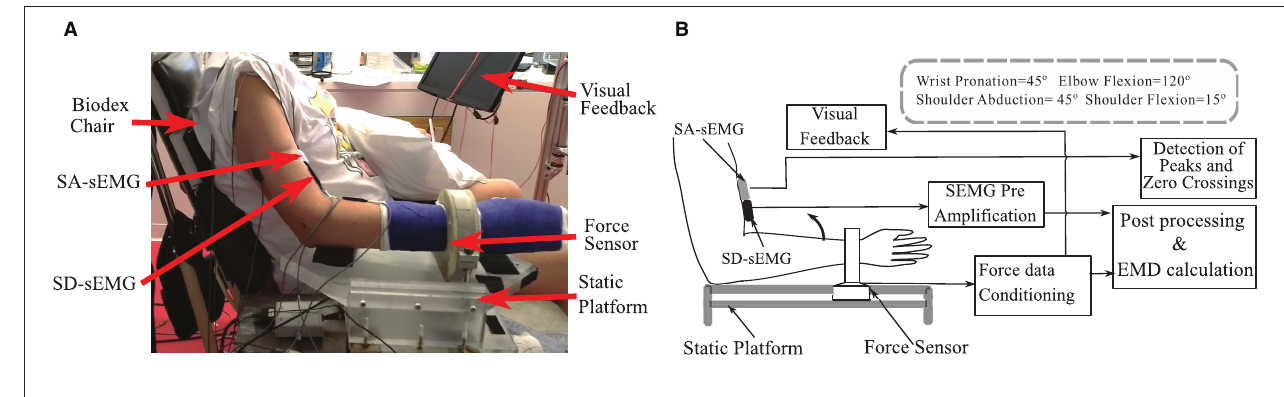
FIGURE 1 | (A) The experimental setup and the position details of the force sensor, Single differential (SD-sEMG) sensor and Sensor Array (SA-sEMG) sensors. (B) Diagram of the data processing framework.